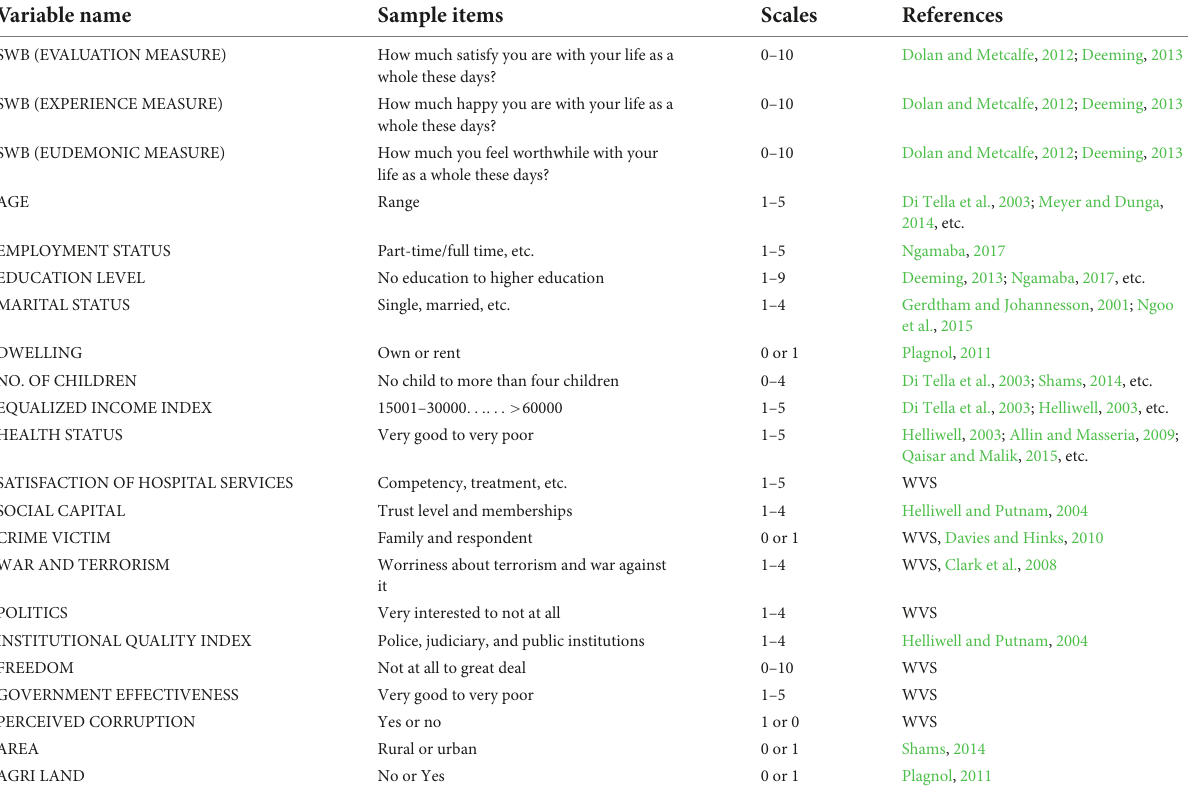
than the average. Figure 3 highlighted the facts about life worthwhile that show more percentage lie above the average proportion for life